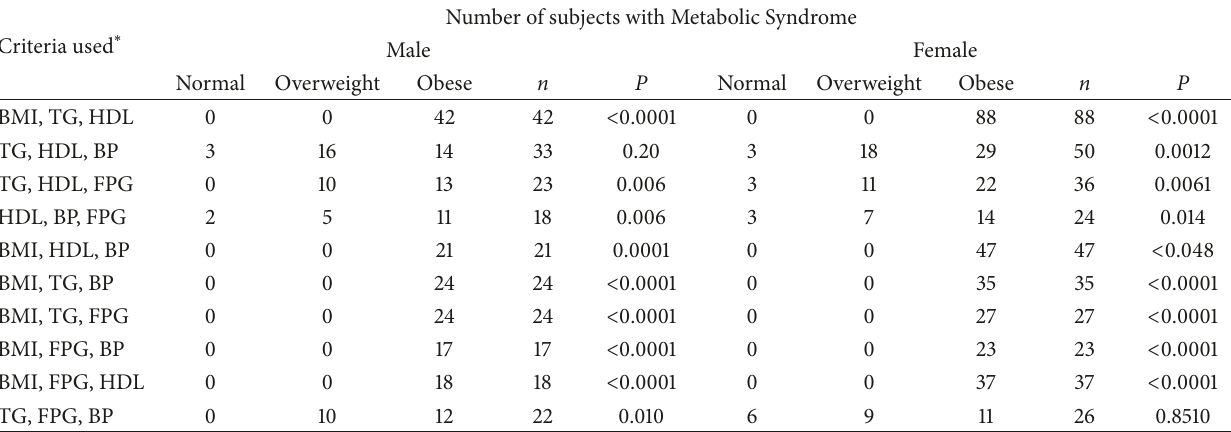
Table 5: Identification of the Metabolic Syndrome in Central and South Americans using all combinations of any three criteria. Number of subjects with Metabolic Syndrome Criteria used ∗ Normal TG, HDL,